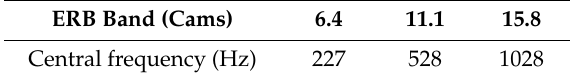
Table 4. Central frequencies of cut-o ff points of ERB bands.